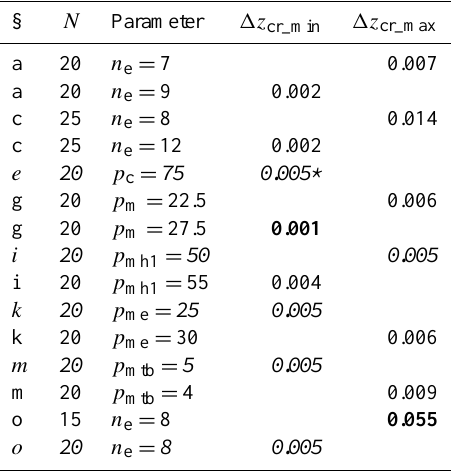
Table 10. Minimum ( t b_min ) and maximum ( t b_max ) base times of the average kernel (only experiments with (cid:56) max = 1 are consid- ered). In the first column, the letters refer to Fig. 19. In bold, the best and worst experiments. An asterisk marks the experiment e , in which (cid:56) max was reached only for p c = 75. In italics, the combina- tions of parameters of the benchmark experiment (cf. Table 4).